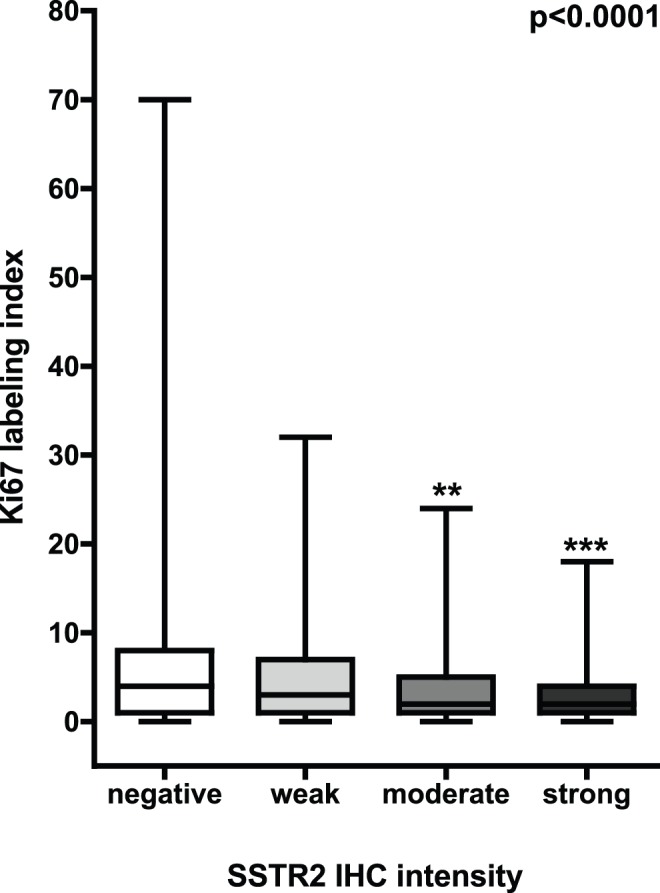
Ki67 labeling index and SSTR2 immunohistochemistry (IHC) in prostate cancer cells.Ki67 labeling index shows a strong inverse correlation with SSTR2 staining intensities (p<0.0001, ANOVA, Dunn’s multiple comparison post-hoc test, box-and-whiskers graph plotting median, 25th and 75th percentile, ** = p<0.01 vs. negative SSTR2 IHC, *** = p<0.001 vs. negative SSTR2 IHC).